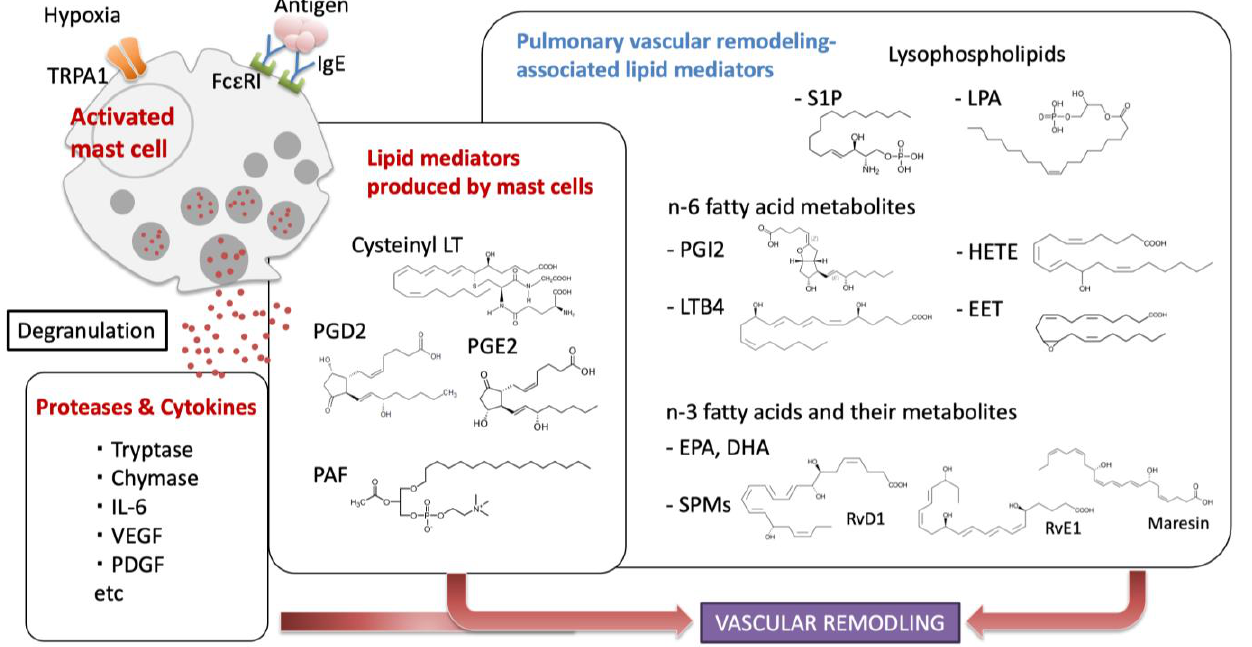
Figure 1. Mechanisms of vascular remodeling by mast cells and various lipid mediators.